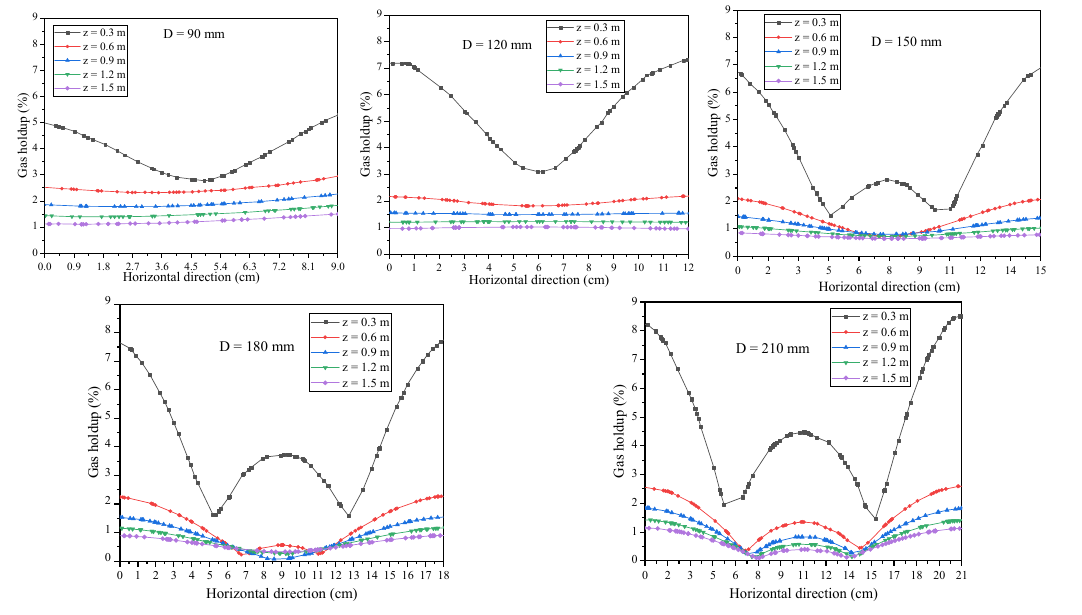
Figure 16. Gas holdup variation along the horizontal direction at different orifice spacings.